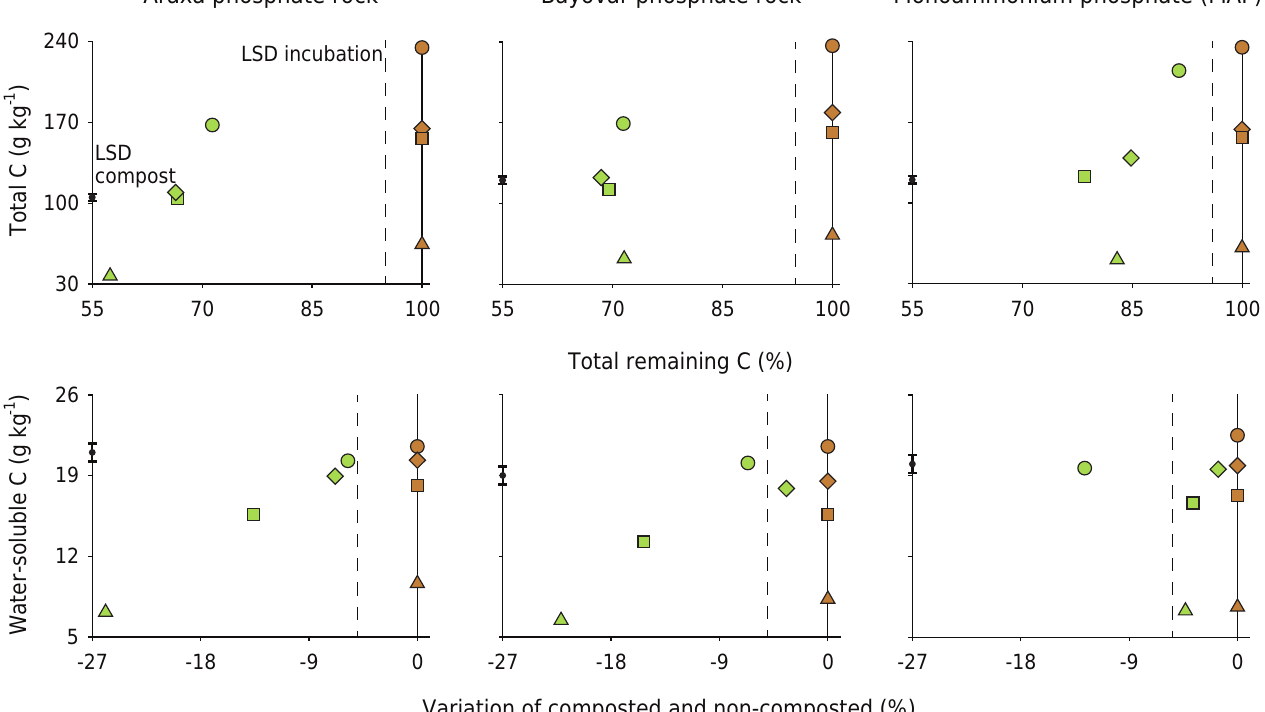
Figure 2. Total C and water-soluble C contents in composted mixtures (150 days of incubation) and non-composted mixtures (without incubation) for different proportions of chicken manure (CM), coffee husk (CH), and Araxá phosphate rock, Bayóvar phosphate rock, or MAP. LSD: Least Significant Difference by the Tukey test (p<0.05) for compost and incubation.